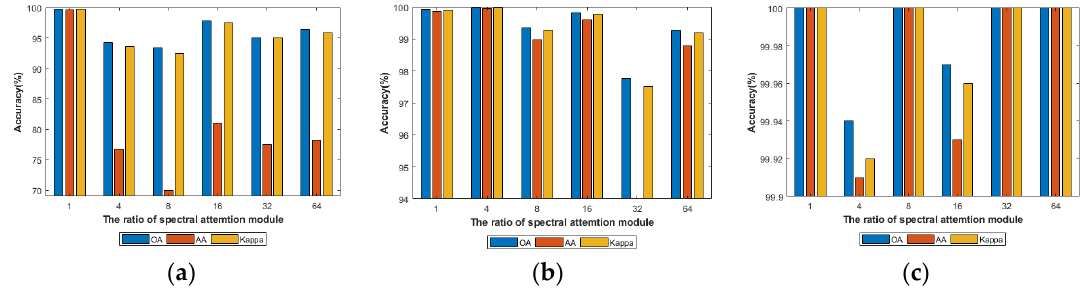
Figure 12. The influence of different ratios of channel-wise attention module. ( a – c ) represent the influence of different ratios on IN, KSC and SA, respectively.